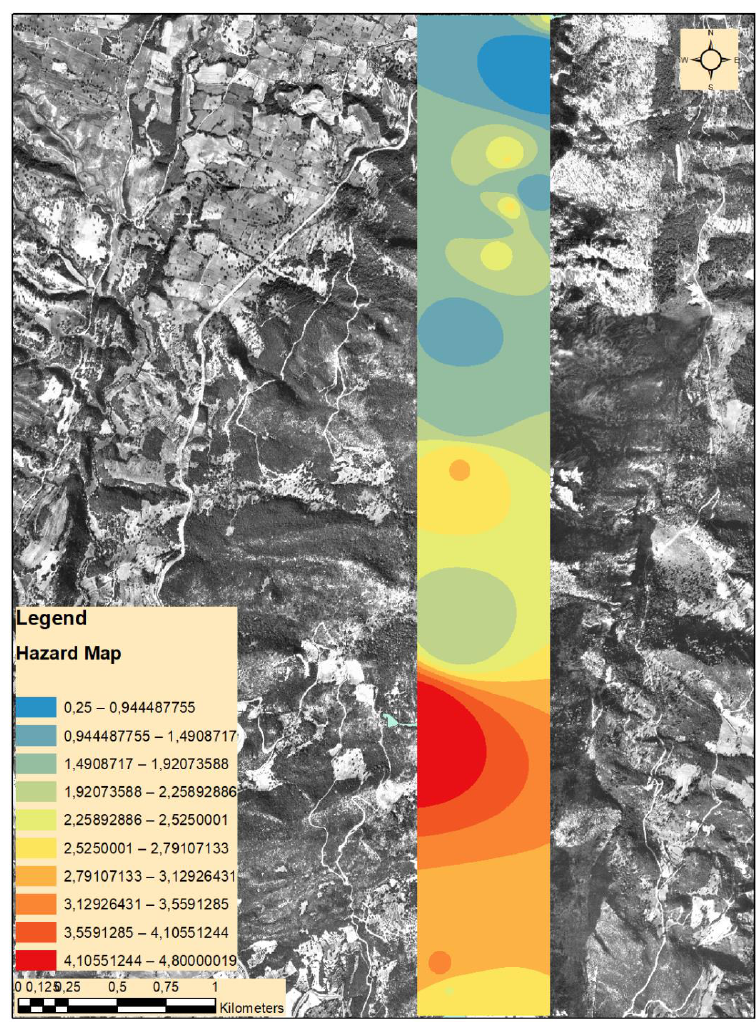
Figure 14. Hazard map of the area between Portes in the south and Santomerion villages in the north.